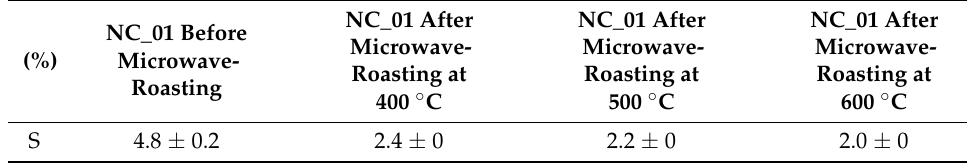
Table A13. Sulphur and hematite content of the Neves Corvo waste rock (NC_01) before and after microwave roasting obtained by X-ray fluorescence (XRF). Values are the average of duplicate samples ± standard